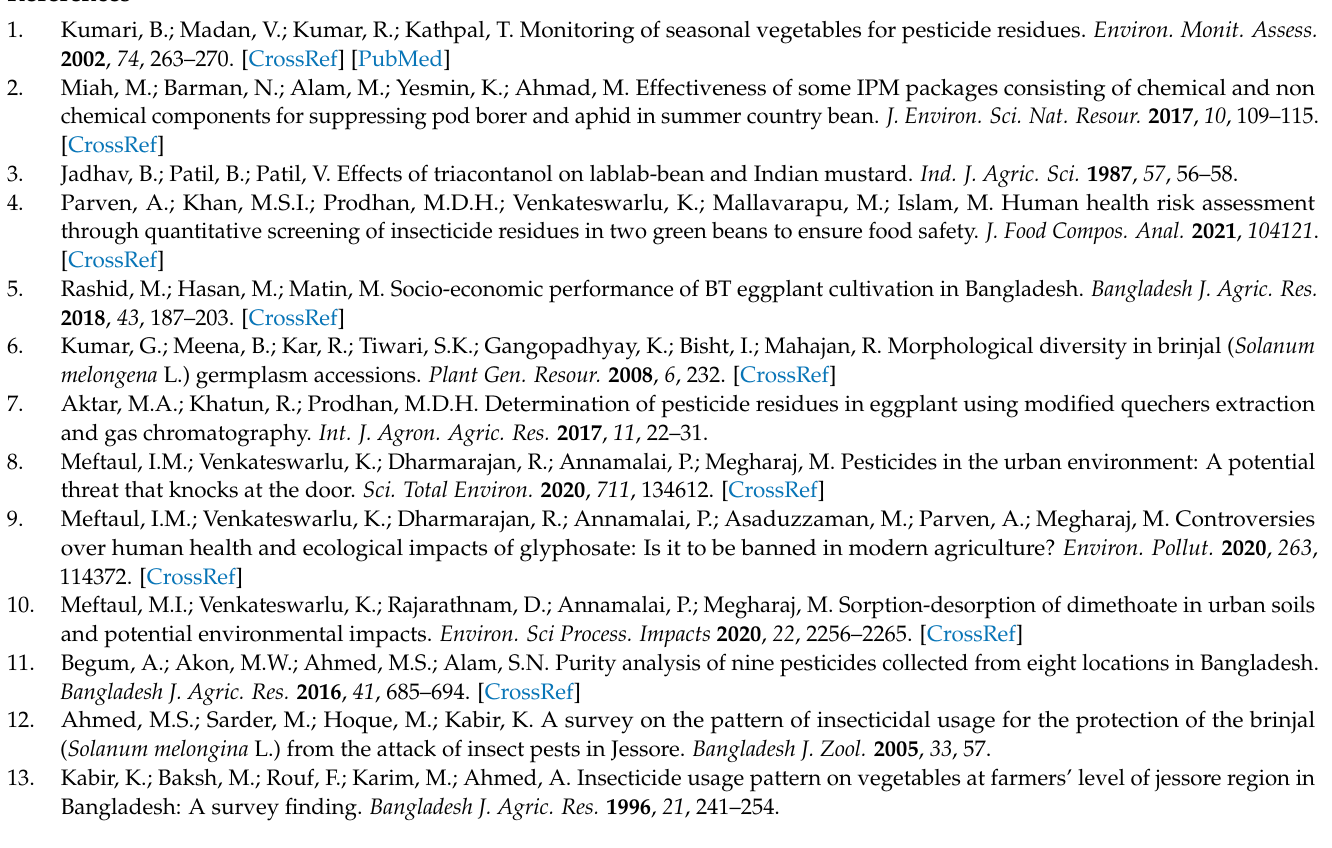
in one of the bean samples (B-10) collected from Sagardi Bazar. Figure S3: Chromatogram of acetamiprid found in one of the bean samples (B-18) collected from Chowmatha Bazar. Figure S4: Chromatogram of cypermethrin found in one of the bean samples (B-21) collected from Notun Bazar. Figure S5: Chromatogram of cypermethrin found in one of the bean samples (B-28) collected from Nothullabad Bazar. Figure S6: Chromatogram of cypermethrin found in one of the eggplant samples (E-06) collected from Rupatoli Bazar. Figure S7: Chromatogram of cypermethrin found in one of the eggplant samples (E-11) collected from Sagardi Bazar. Figure S8: Chromatogram of cypermethrin found in one of the eggplant samples (E-17) collected from Chowmatha Bazar. Figure S9: Chromatogram of acetamiprid found in one of the eggplant samples (E-23) collected from Notun Bazar. Table S1: The instrumental conditions for GC-ECD. Table S2: Linear regression parameters and LOQ of the four selected pesticides in the external added standard